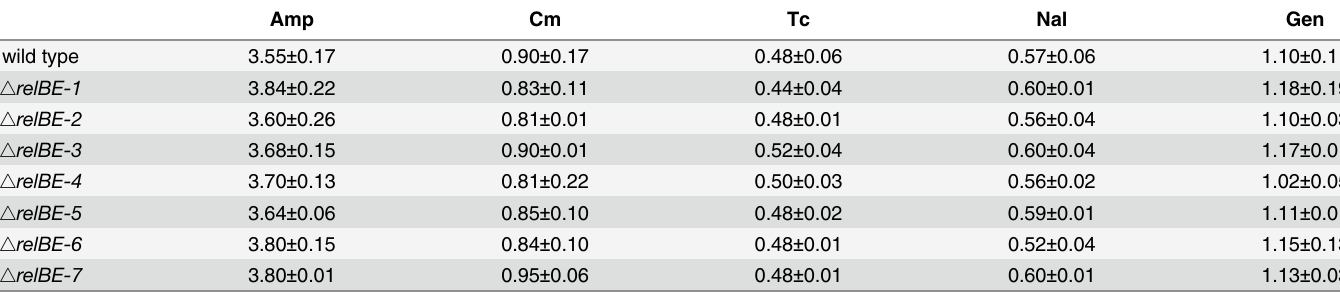
Table 2. MIC for TA loci knockout